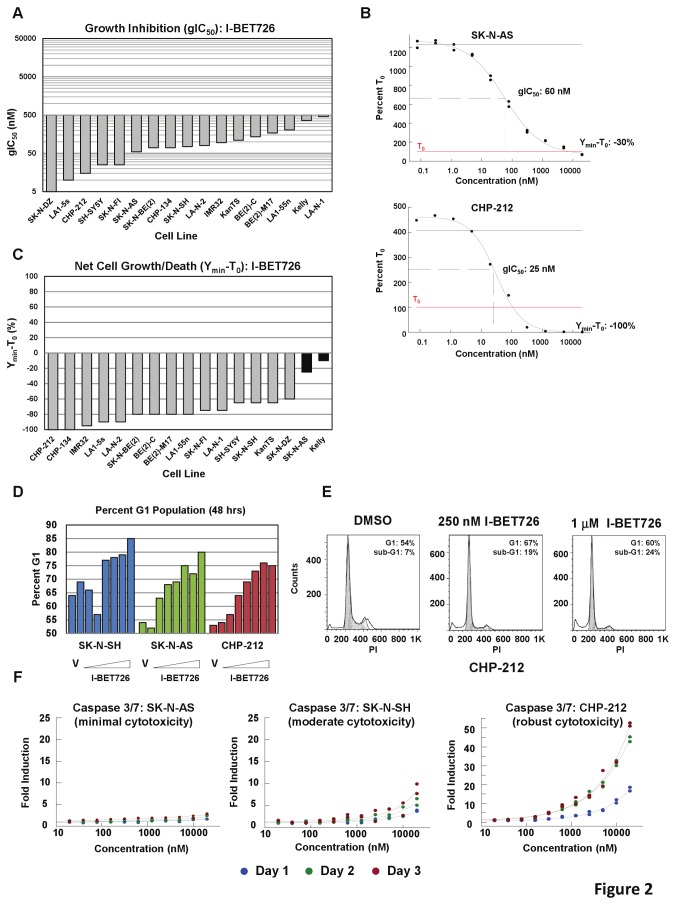
I-BET726 treatment results in potent growth inhibition and cytotoxicity in neuroblastoma cell lines.(a) gIC50 values observed for I-BET726 in a panel of neuroblastoma cell lines obtained from a 6 day growth-death assay. (b) Concentration response curves for SK–N-AS and CHP-212 from 6 day growth-death assay. Black horizontal line indicates growth in DMSO-treated controls. Red line indicates T0 value (100%). gIC50 and Ymin-T0 values are indicated. Data presented as the average of two independent curves from a single experiment, and is representative of data from three independent biological replicates. (c) Ymin-T0 values observed for I-BET726 in the panel of neuroblastoma cell lines obtained from a 6 day growth-death assay. Gray bars indicate a cytotoxic response, defined by a Ymin-T0 value ≤ -50, with evidence of net cell death (Y < T0) along the growth curve at concentrations less than 6 µM. (d) Graph summarizing number of cells in G1 phase (as a percent of total cell population) in the indicated neuroblastoma cell lines following treatment with a titration of I-BET726 (5 nM-20 000 nM) for 2 days based on propidium iodide staining. V represents vehicle (DMSO) control sample. (e) Histograms generated from cell cycle analysis in the CHP-212 cell line following 4 days treatment with the indicated concentration of I-BET726. Percentage of cells in G1 phase and sub-G1 phase are indicated. (f) Caspase induction in the indicated neuroblastoma cell lines following treatment with a titration of I-BET726 for one, two, or three days. Data is presented as fold induction over DMSO controls, following normalization to total cell number as measured by CellTiter-Glo.